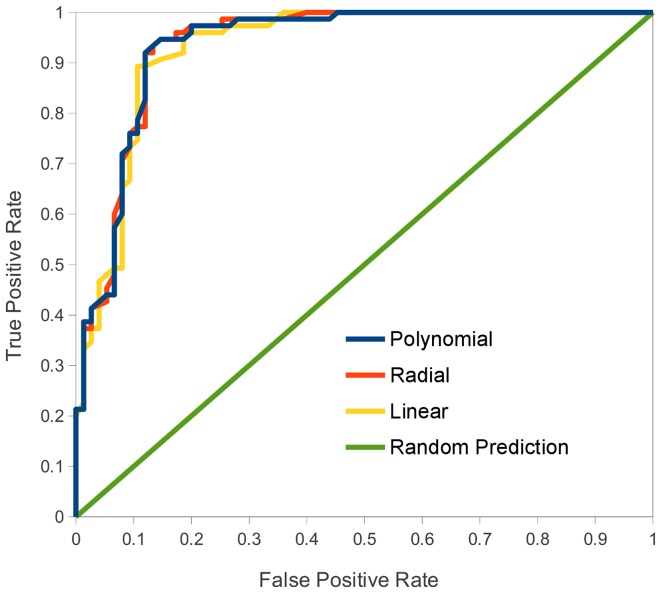
ROC curves for the CS-AMPPred models against the blind data set (BS1).